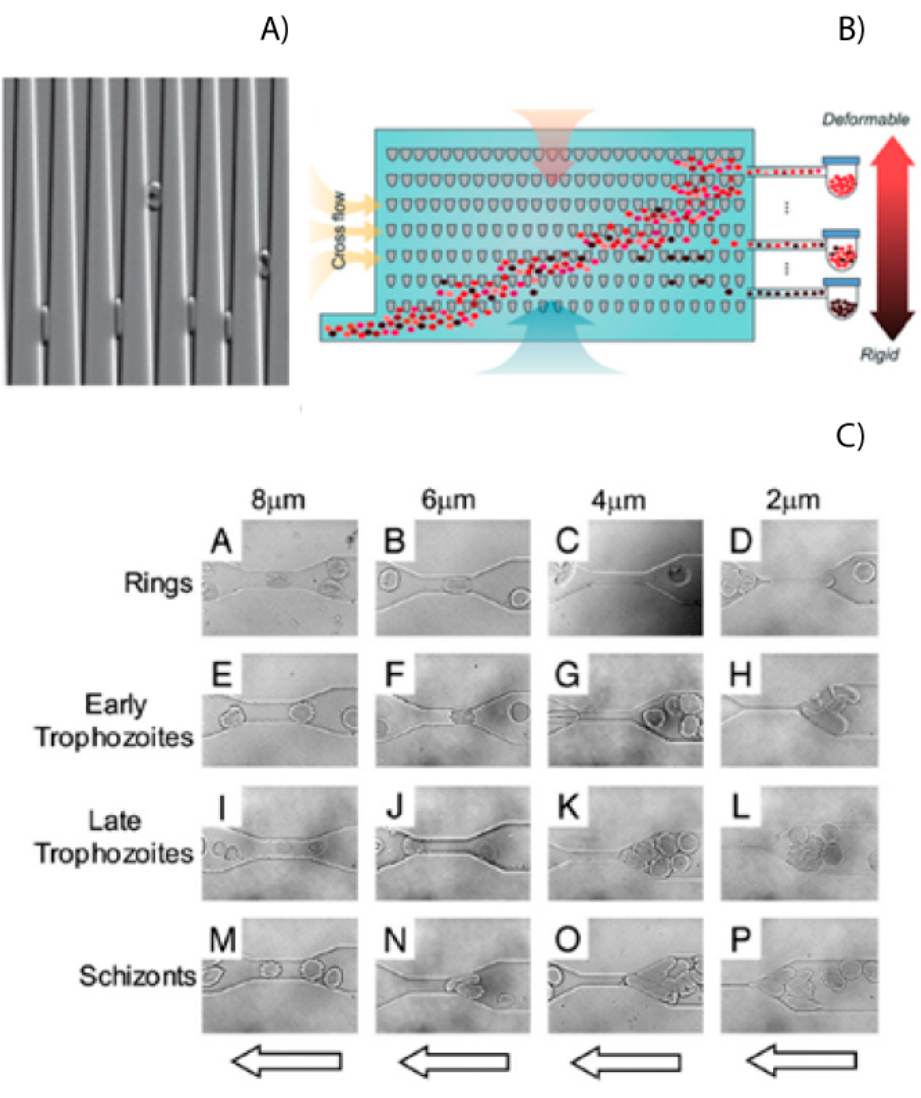
Figure 3. ( A ) RBCs and iRBCs in funnel shaped channels. The higher the deformability, the further the cells can travel downwards. Reprinted with permission from ref. [38] © 2009 Cellular Microbi- ology ( B ) Cell sorting by deformability using a matrix of funnel constrictions. Reprinted with permission from ref. [42] © 2016 The Royal Society of Chemistry ( C ) RBC traversing gaps in microchannels. Depending on the stage of the infection, the iRBC will become increasingly less deformable. Reprinted with permission from ref. [37] © 2003 National Academy of Sciences.